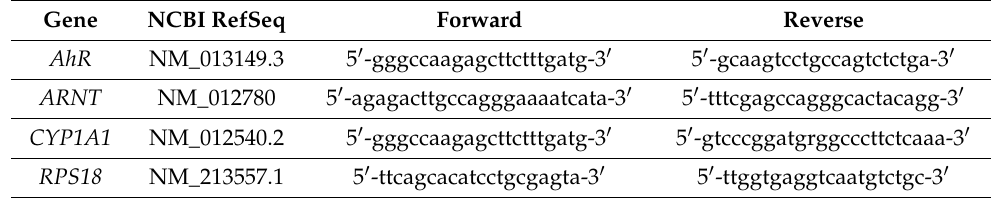
Table 1. Primer sequences for amplification of rat AhR , ARNT , CYP1A1, and RPS18 by real-time